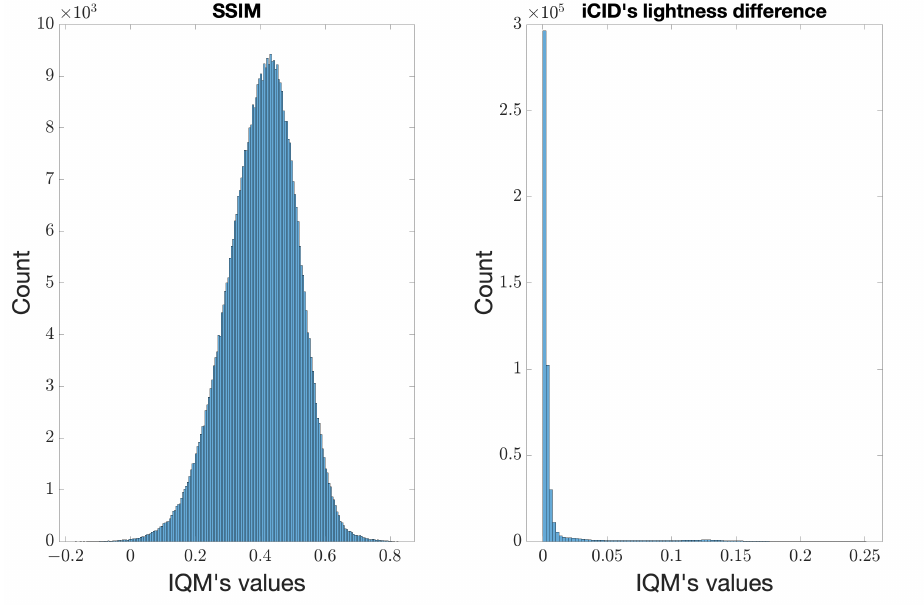
Figure 5. The histograms of SSIM and iCID’s lightness difference mean quality maps for the scissor image with 1 mm maximum height print used as test image and 0.25 mm maximum height print used as reference image from the MS captures. The histograms show that iCID’s lightness difference map detects more differences between prints around zero whereas SSIM detects more spread